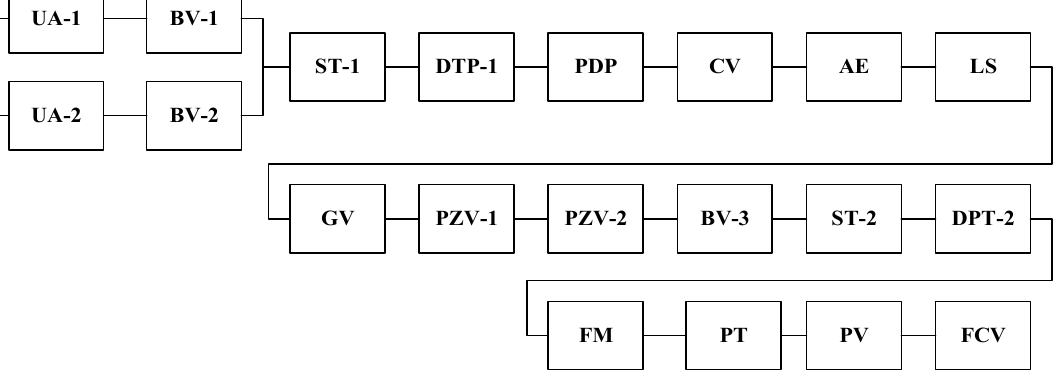
Figure 2. Unloading system reliability block diagram.